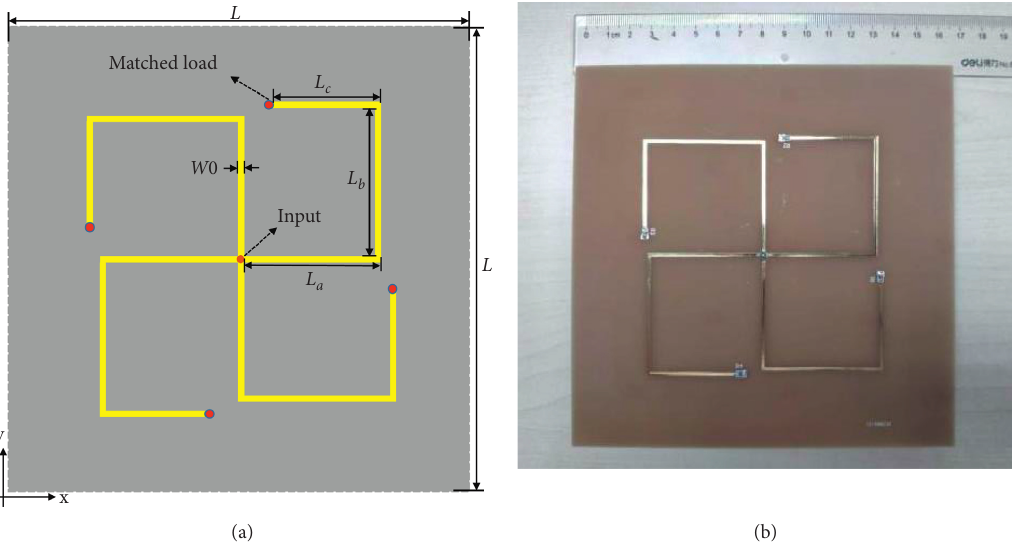
Figure 2: Configuration of the four-branch antenna. (a) Schematic diagram of structure. (b) Physical processing diagram.